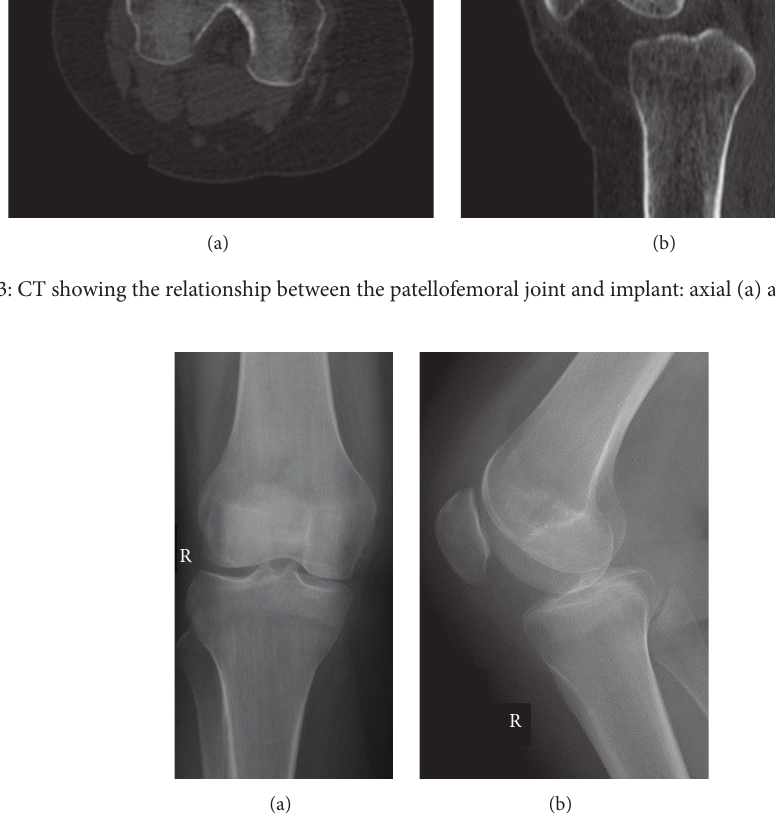
Figure 4: Anteroposterior (a) and lateral (b) follow-up X-rays after the second